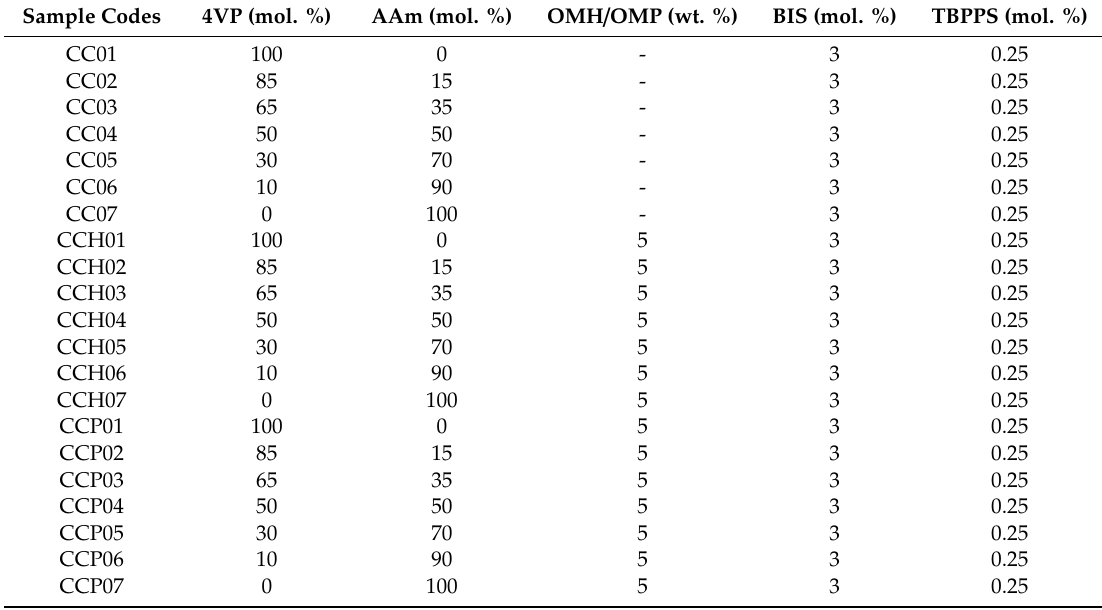
Table 1. Experimental data of the synthesized samples. 4VP—4-vinylpyridine; AAm—acrylamide; OMH—organo-modified with hexadecyltrimethylammonium bromide; OMP—organo-modified